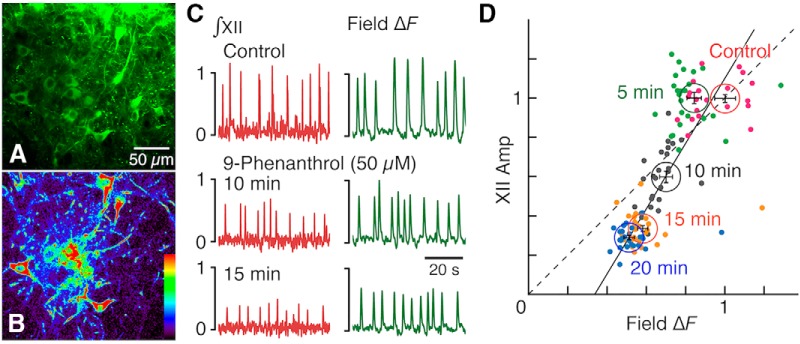
Perturbations of imaged pre-BötC inspiratory Ca2+ activity and electrophysiologically recorded hypoglossal motor output in the VgluT2-GCaMP6f transgenic mouse in vitro slice during application of TRPM4 channel inhibitor. A, Example of two-photon single optical plane image showing Cre-dependent GCaMP6f expression in pre-BötC glutamatergic neurons. B, Background subtracted (F – F0) ΔF image showing increased GCaMP6f fluorescence of individual neurons for the optical plane shown in A. C, Integrated inspiratory hypoglossal activity (∫ XII) and the spatially averaged field GCaMP6f fluorescence transients (ΔF), quantified as F – F0, of the optical plane shown in A during control time, and 10 and 15 min after bath-application of 9-phenanthrol (50 µm). D, Inspiratory burst-wise correlations of the field fluorescence ΔF and ∫ XII amplitudes (XII Amp; colored dots), and their grouped averages (circles with error cross bars: mean values ± SEM), normalized to their control values, for time windows 5, 10, 15, and 20 min after 9-phenanthrol application. Note that the 15- and 20-min point clusters are nearly superimposed, indicating quasi–steady state of the perturbations was achieved by 20 min. The identity line (dashed) and linear regression line (solid; Pearson correlation coefficient r = 0.74) indicate significant correlation between peak field ΔF and XII Amp.